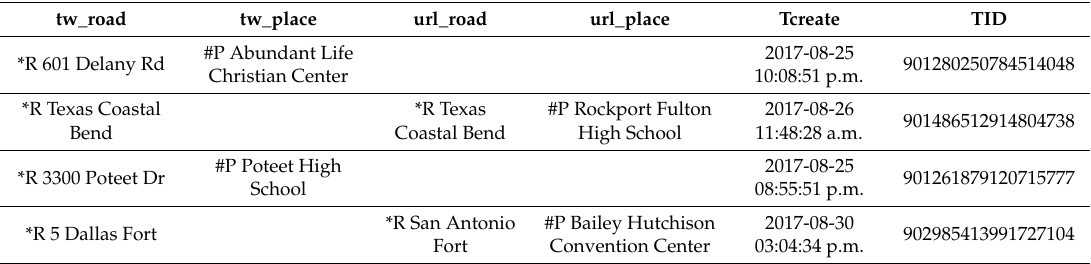
Table 2. Gazetteer table with Twitter ID.